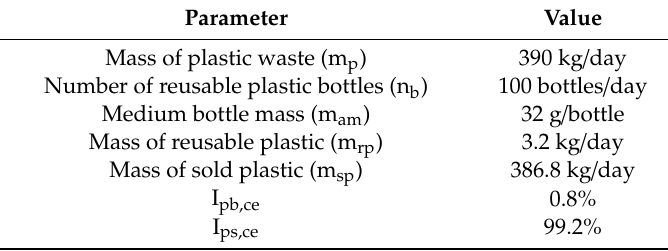
Table 3. Circular economy indicators for reutilization and revalorization of plastic fraction.